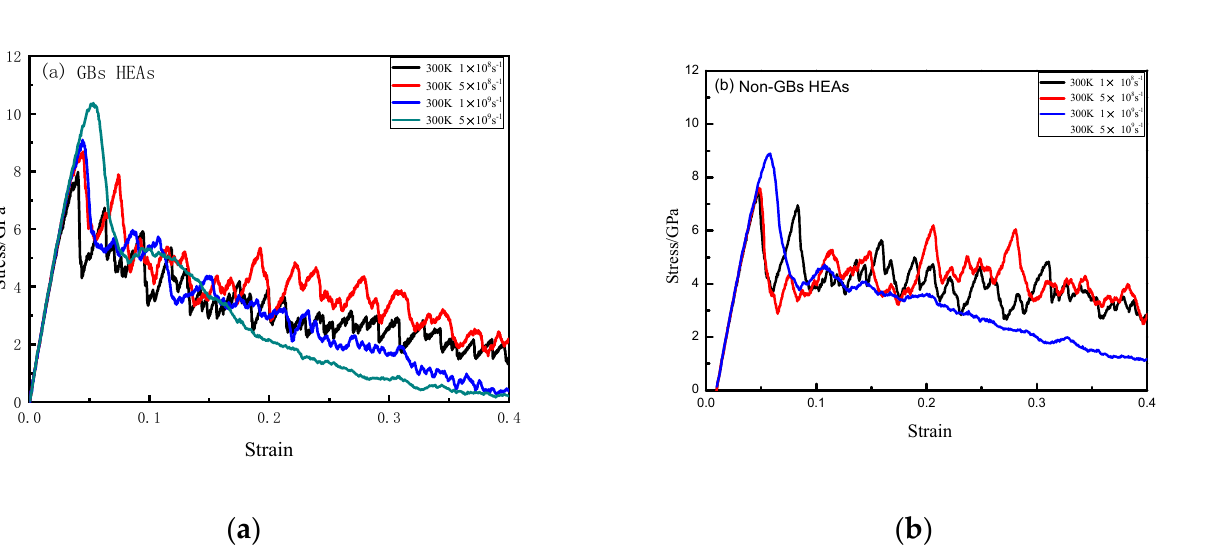
Figure 5. Stress-strain curves of deformation process at different strain rates of HEA. ( a ) GBs HEAs; ( b ) non-GBs HEAs .